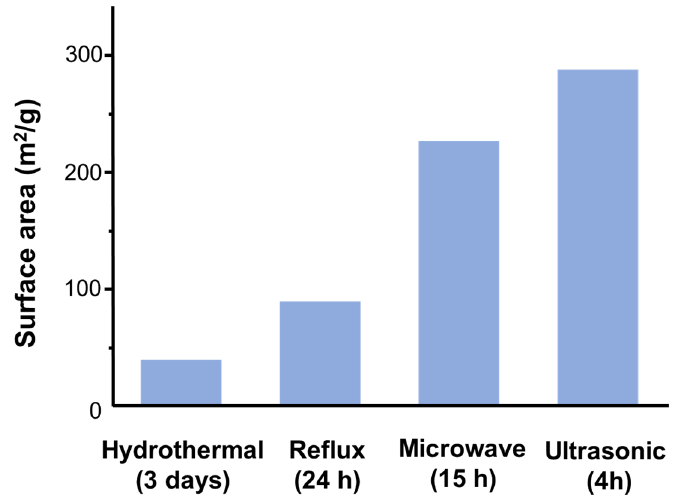
Figure 5. Influence of synthetic methodology on the surface area value (N 2 , 77K) obtained for pure K–OMS–2. The synthesis time is indicated in parenthesis. Data are obtained from [114].